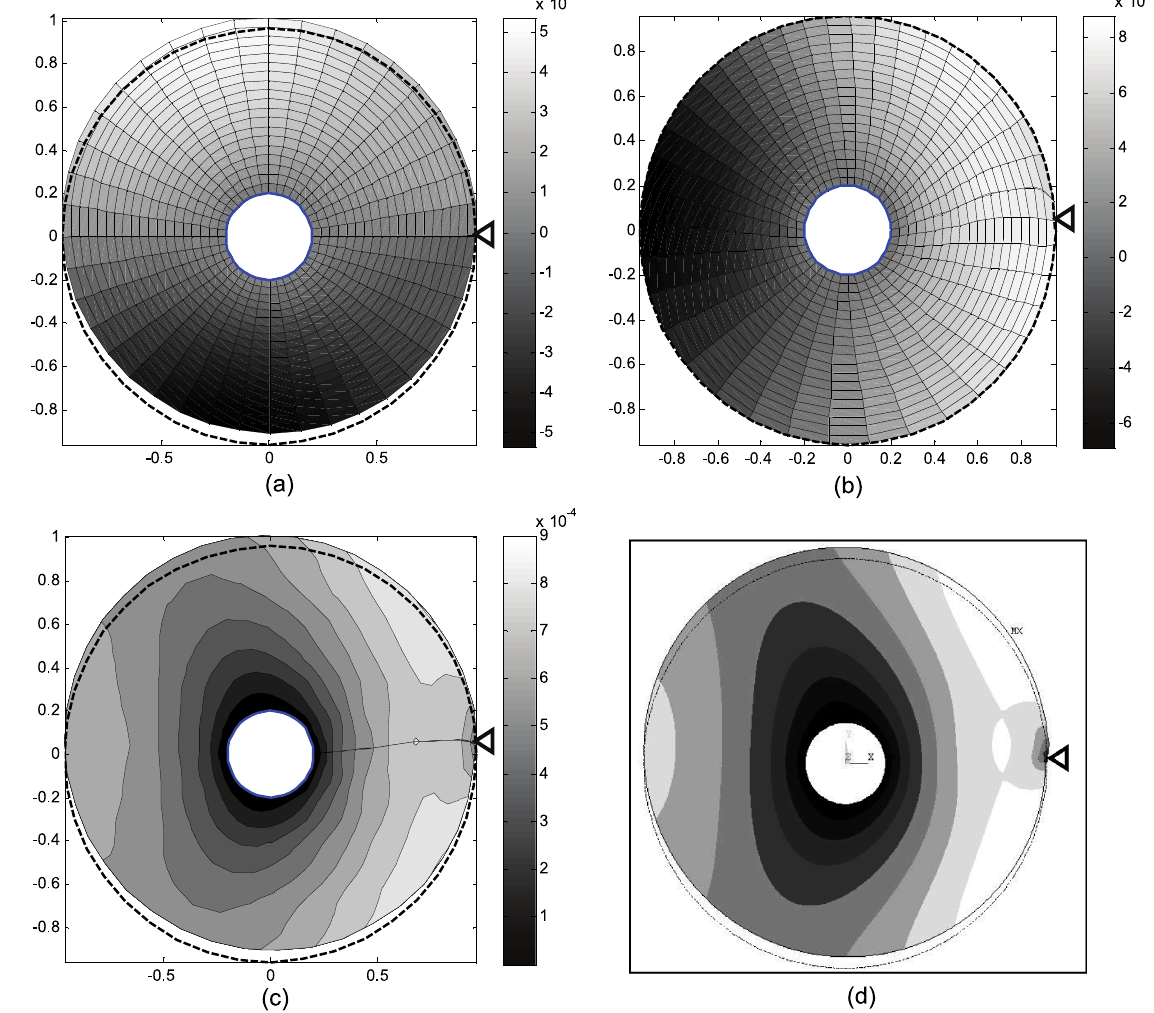
Fig.9. Contourdeformationplotsforoddmode(0,1)fora‘Clamped-PointClamped’disk: a)radialdisplacement; b)circumferentialdisplacement, c) vector sum of displacements; d) deformed shape from Finite element model, : point clamped support , undeformed